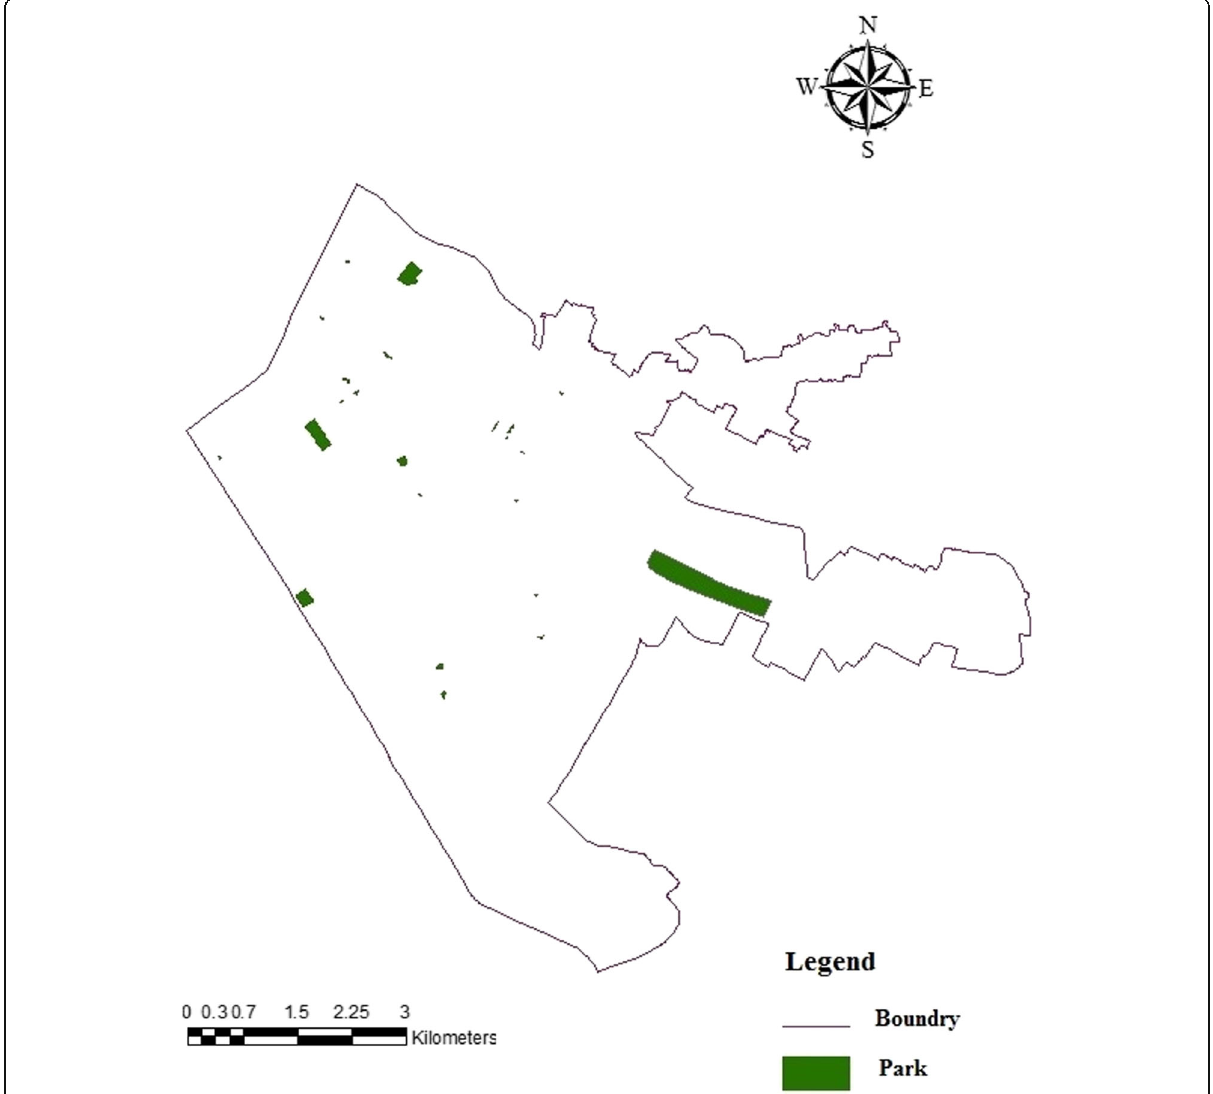
Fig. 11 Layers with the value of one for the temporary accommodation in the